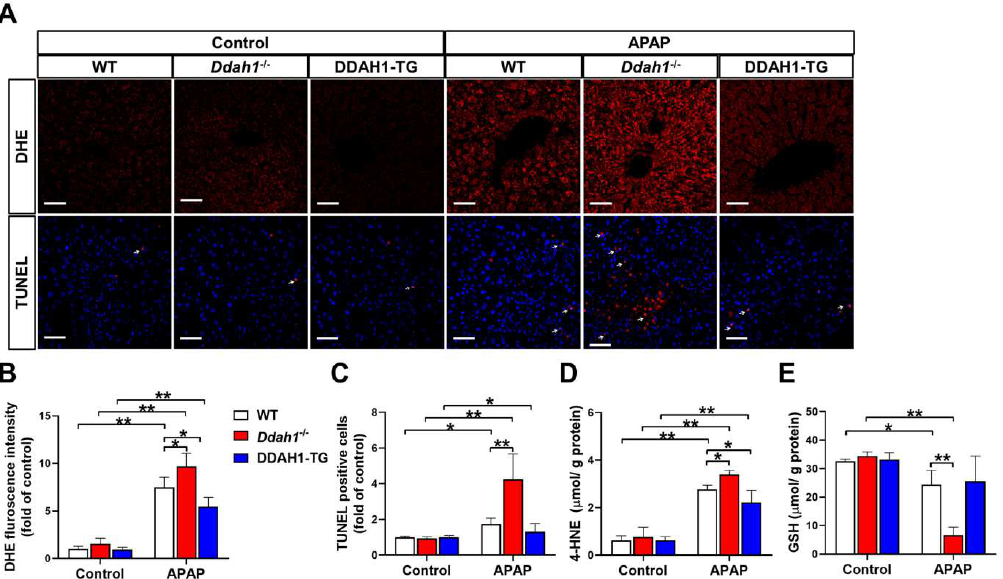
Figure 2. DDAH1 alleviates oxidative stress and apoptosis in APAP-treated mice. ( A ) Liver sections from control and APAP-exposed mice were stained with dihydroethidium (DHE) and a TUNEL assay kit (red) and DAPI (blue) (scale bar = 50 μm). The relative fluorescence intensities of DHE ( B ) and the TUNEL-positive cells ( C ) were quantified. After APAP treatment, 4-HNE ( D ) and GSH ( E ) levels in the liver were measured. n = 5, values are expressed as means ± SD; * indicates p < 0.05; ** indicates p < 0.01.